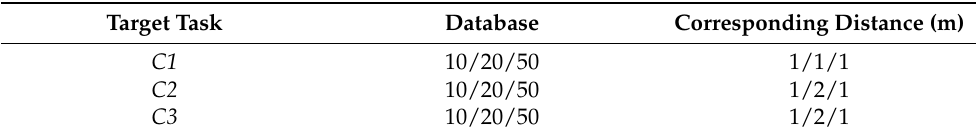
Table 2. Target task